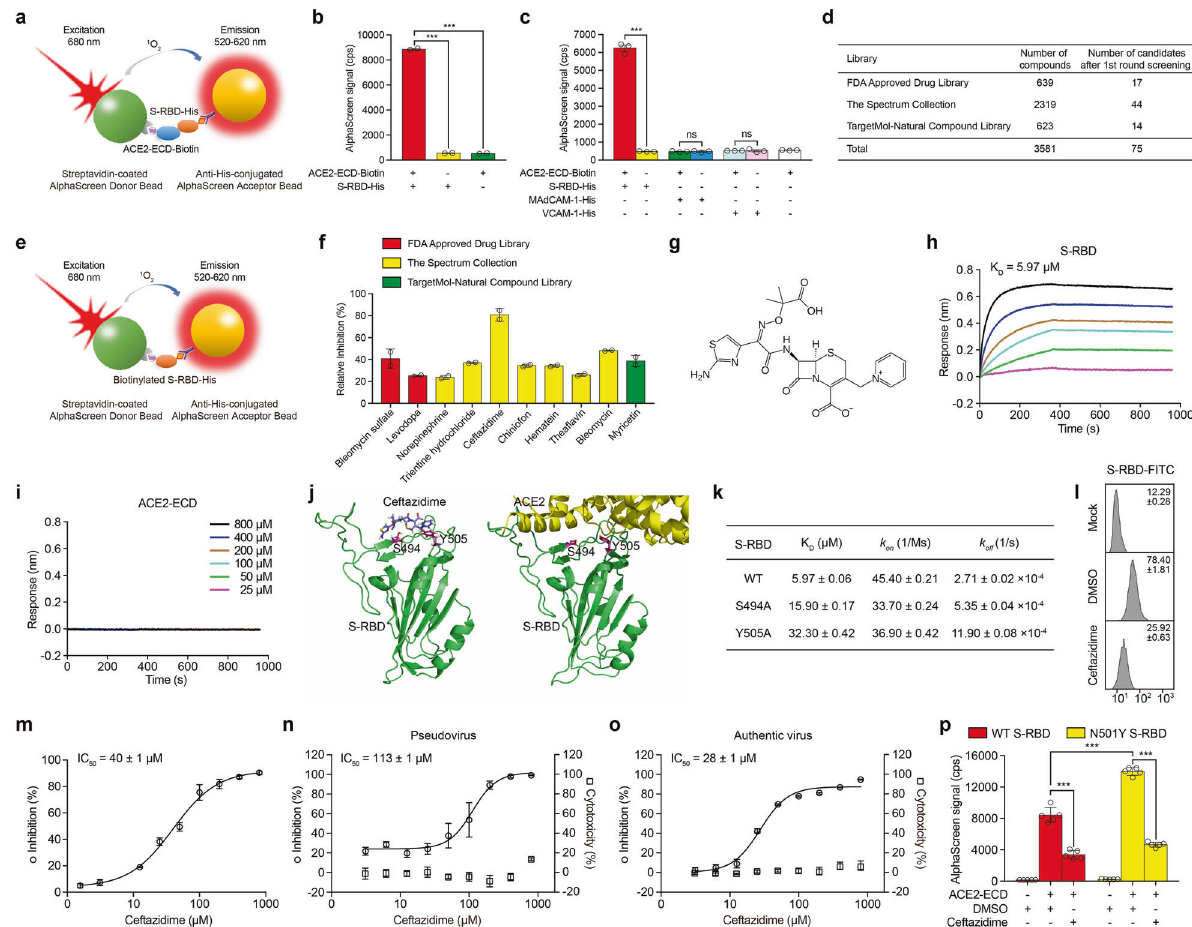
Fig. 1 Inhibition of SARS-CoV-2 infection in vitro by ceftazidime. a Schematic diagram of AlphaScreen system to detect the interaction between S-RBD and ACE2-ECD, adapted from PerkinElmer application notes. The donor and acceptor beads are coated with streptavidin and anti-His monoclonal antibody, respectively. b The interaction between S-RBD and ACE2-ECD was monitored using AlphaScreen system. c Comparison of the AlphaScreen signal of S-RBD-His, MAdCAM-1-His and VCAM-1-His proteins in the presence or not of ACE2-ECD-Biotin in AlphaScreen system. d Libraries used in AlphaScreen-based high-throughput system and 75 candidates were identi fi ed from 3581 compounds in positive selection. The inhibition rate was calculated by the decrease of AlphaScreen signal of each compound compared with that of DMSO vehicle control group. All the compounds showed over 45% inhibition rate were de fi ned as positive candidates. e Schematic diagram of negative selection using AlphaScreen system, adapted from PerkinElmer application notes. Biotinylated S-RBD-His simultaneously links streptavidin-coated donor bead and anti-His-conjugated acceptor bead together to generate AlphaScreen signal directly. f Relative inhibition of 10 candidate compounds on S-RBD – ACE2 interaction using AlphaScreen system. The relative inhibition rate was calculated by subtracting the inhibition rate in negative selection from that in positive selection. g Molecular structure of ceftazidime. Binding of ceftazidime to S-RBD ( h ) or ACE2-ECD ( i ) was measured by BLI experiments in an Octet RED96 instrument. The biotin-conjugated S-RBD or ACE2-ECD was captured by streptavidin that was immobilized on a biosensor and tested for binding with gradient concentrations of ceftazidime. j Snapshot of the lowest energy binding pose of ceftazidime – S-RBD based on MD simulation (left) and the crystal structure of S-RBD and ACE2 complex (PDB code 6M0J) (right). k Binding capacity of ceftazidime to WT and mutated S-RBD. The values of K D , k on and k off for the binding of ceftazidime to WT and mutated S-RBD (S494A and Y505A) were obtained by BLI experiments (K D = k off / k on ). l Soluble S-RBD binding to HPAEpiC cells was examined by fl ow cytometry analysis. Mock, cells were incubated with FITC-conjugated goat anti-human IgG; DMSO, vehicle control; Ceftazidime, 100 μ M ceftazidime in DMSO. Numbers within the panel showed the speci fi c mean fl uorescence intensities. m The inhibitory effect of ceftazidime on the binding of S-RBD protein to HPAEpiC cells. Cells were treated with different concentrations of ceftazidime. The inhibition rate was calculated by the decrease of the mean fl uorescence intensity of each group compared with that of DMSO vehicle control group. IC 50 was indicated in the graph. n , o Cells were treated with DMSO or serially diluted ceftazidime. Inhibition of luciferase-encoding SARS-CoV-2 typed pseudovirus entry into ACE2-expressing 293T cells by ceftazidime ( n ). Inhibition of authentic SARS-CoV-2 infection of Vero E6 cells by ceftazidime ( o ). IC 50 was indicated in the graph. The cell viability was assessed by Cell Counting Kit-8 (CCK-8) assay and the cytotoxicity (%) of ceftazidime to 293T and Vero E6 cells was calculated by the decrease of optical density (OD) at each concentration of ceftazidime compared with that of DMSO vehicle control. p Effect of ceftazidime on WT/N501Y S-RBD – ACE2 interaction indicated by AlphaScreen signal. DMSO, vehicle control. One representative result of three independent experiments is shown in ( h ), ( i ) and ( l ). Data represent the mean±SEM ( n ≥ 2) in ( b ), ( c ), ( f ) and ( k ) – ( p ). *** p < 0.001; ns not signi fi cant (unpaired two-tailed Student ’ s t test) MM/GBSA analysis to identify the key residues responsible for metadynamic simulation of each replica, the average spatial ceftazidime binding, we found that residues Ser494 (S494) and density distributions of ceftazidime molecules were analyzed, Tyr505 (Y505) at the ACE2 binding interface in S-RBD played key and the lowest energy binding pose was shown (Fig. 1j). After roles in stabilizing ceftazidime binding. Computational alanine extracting MD trajectories at this binding site and performing Signal Transduction and Targeted Therapy (2021)